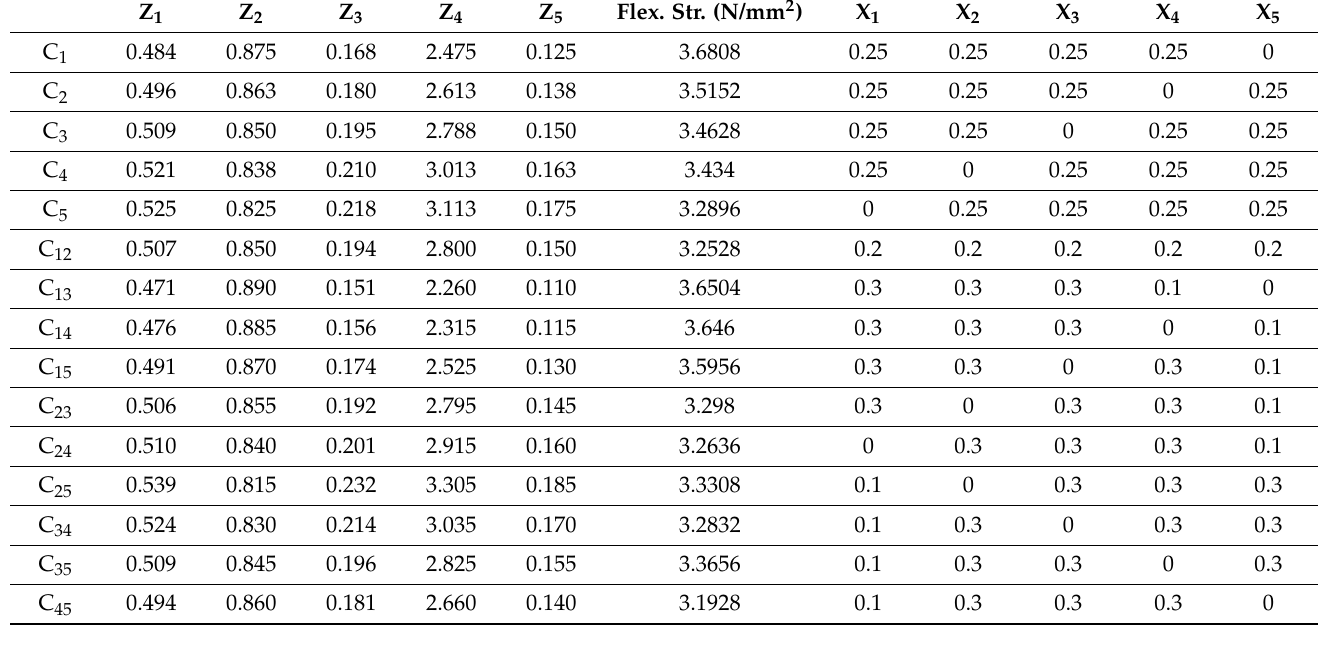
Table 7. Flexural strength response for the control points.